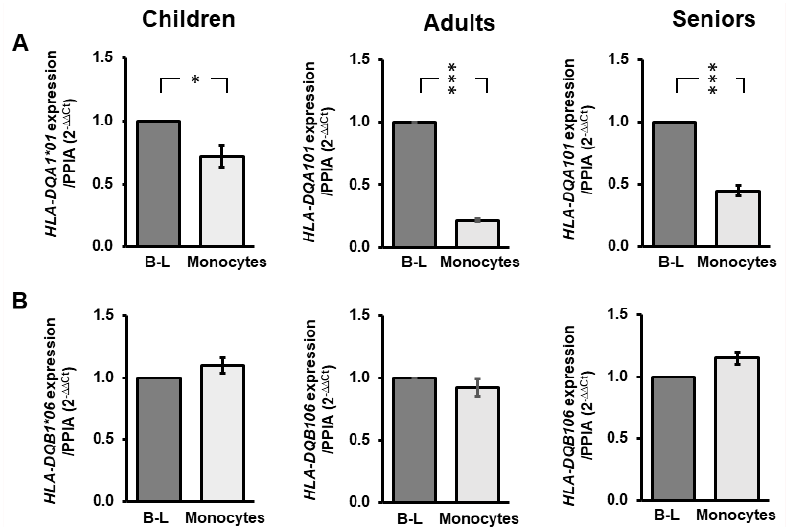
Figure 2. HLA-DQ allelic variants elicit alternative expression profiles in monocytes across age groups. Histograms of HLA-DQA1*01 or HLA-DQB1*06 expression in monocytes compared to B- lymphocytes (B-L) in children, adults, and seniors after normalization to the endogenous control gene Peptidylprolyl isomerase A ( PPIA ) showing differential ( A ) or stability ( B ) levels respectively between age groups. Asterisks represent significant within-group ( n = 4) differences between B- lymphocytes and monocytes (* p = 0.01; *** p < 10 −6 ).